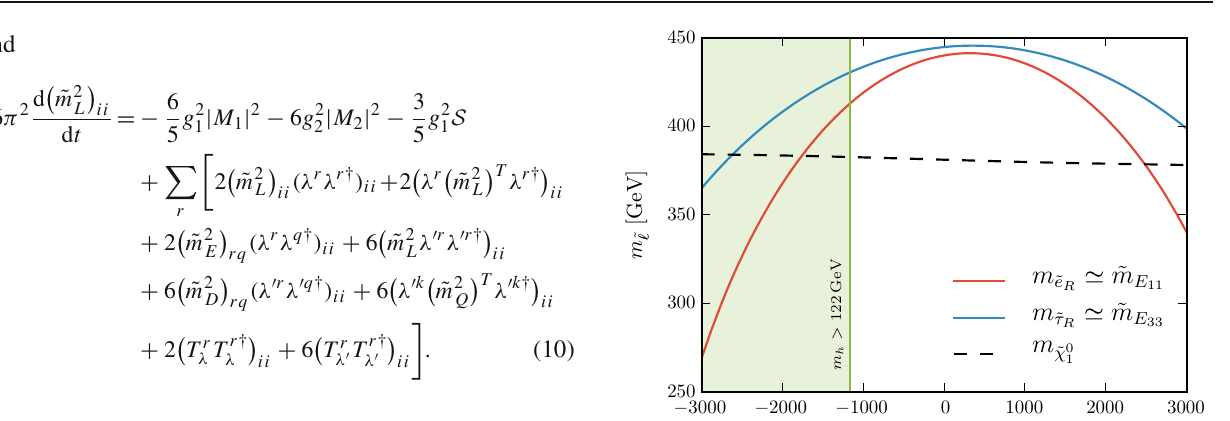
Eqs. (7)–(10), but have been used in the full numerical evalu- ation.For A 0 (cid:2) − 1 .